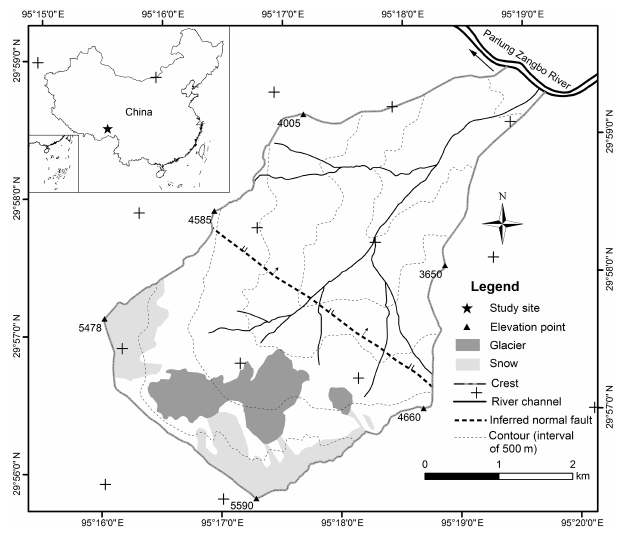
Figure 1. Location of Tianmo Valley and related